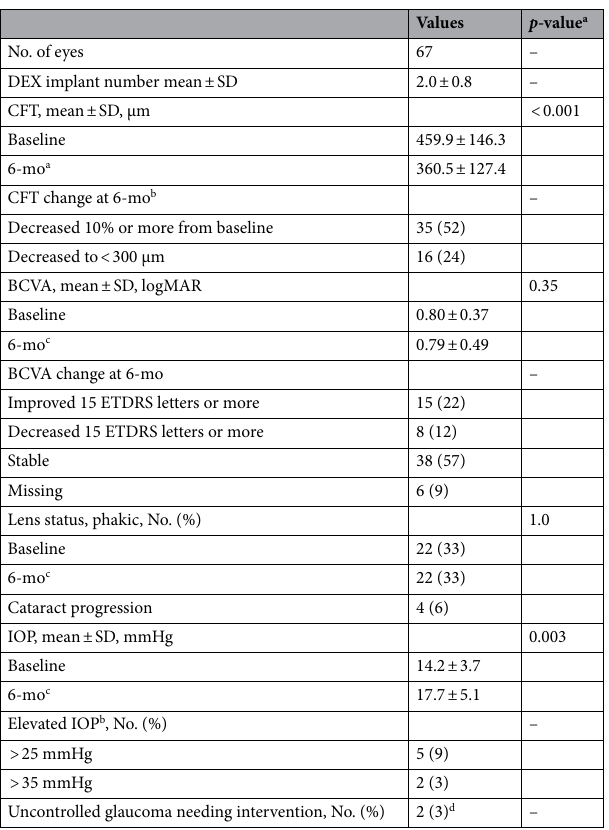
Table 3. Six-month outcomes in eyes with diabetic macular edema treated by DEX implants. a Between the baseline and the 6-mo values. b Valid n = 58. c Valid n = 61. d Two eyes from the same patient with persistent elevated IOP and needed argon laser trabeculoplasty. Abbreviation: BCVA best-corrected visual acuity, CFT central foveal thickness, DEX implant dexamethasone intravitreal implant, IOP intraocular pressure, logMAR logarithm of the minimum angle of